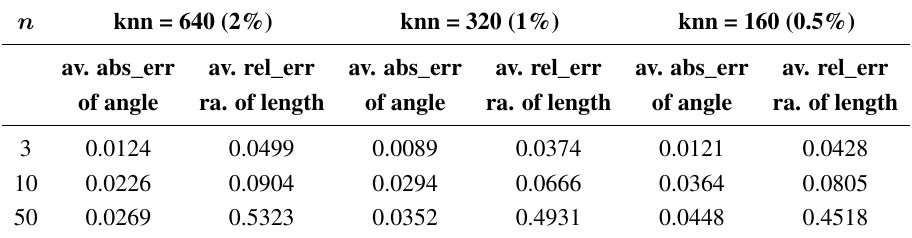
Table 6. The results of (cid:96) MCDA on four superimposed Gaussian distributions. 1